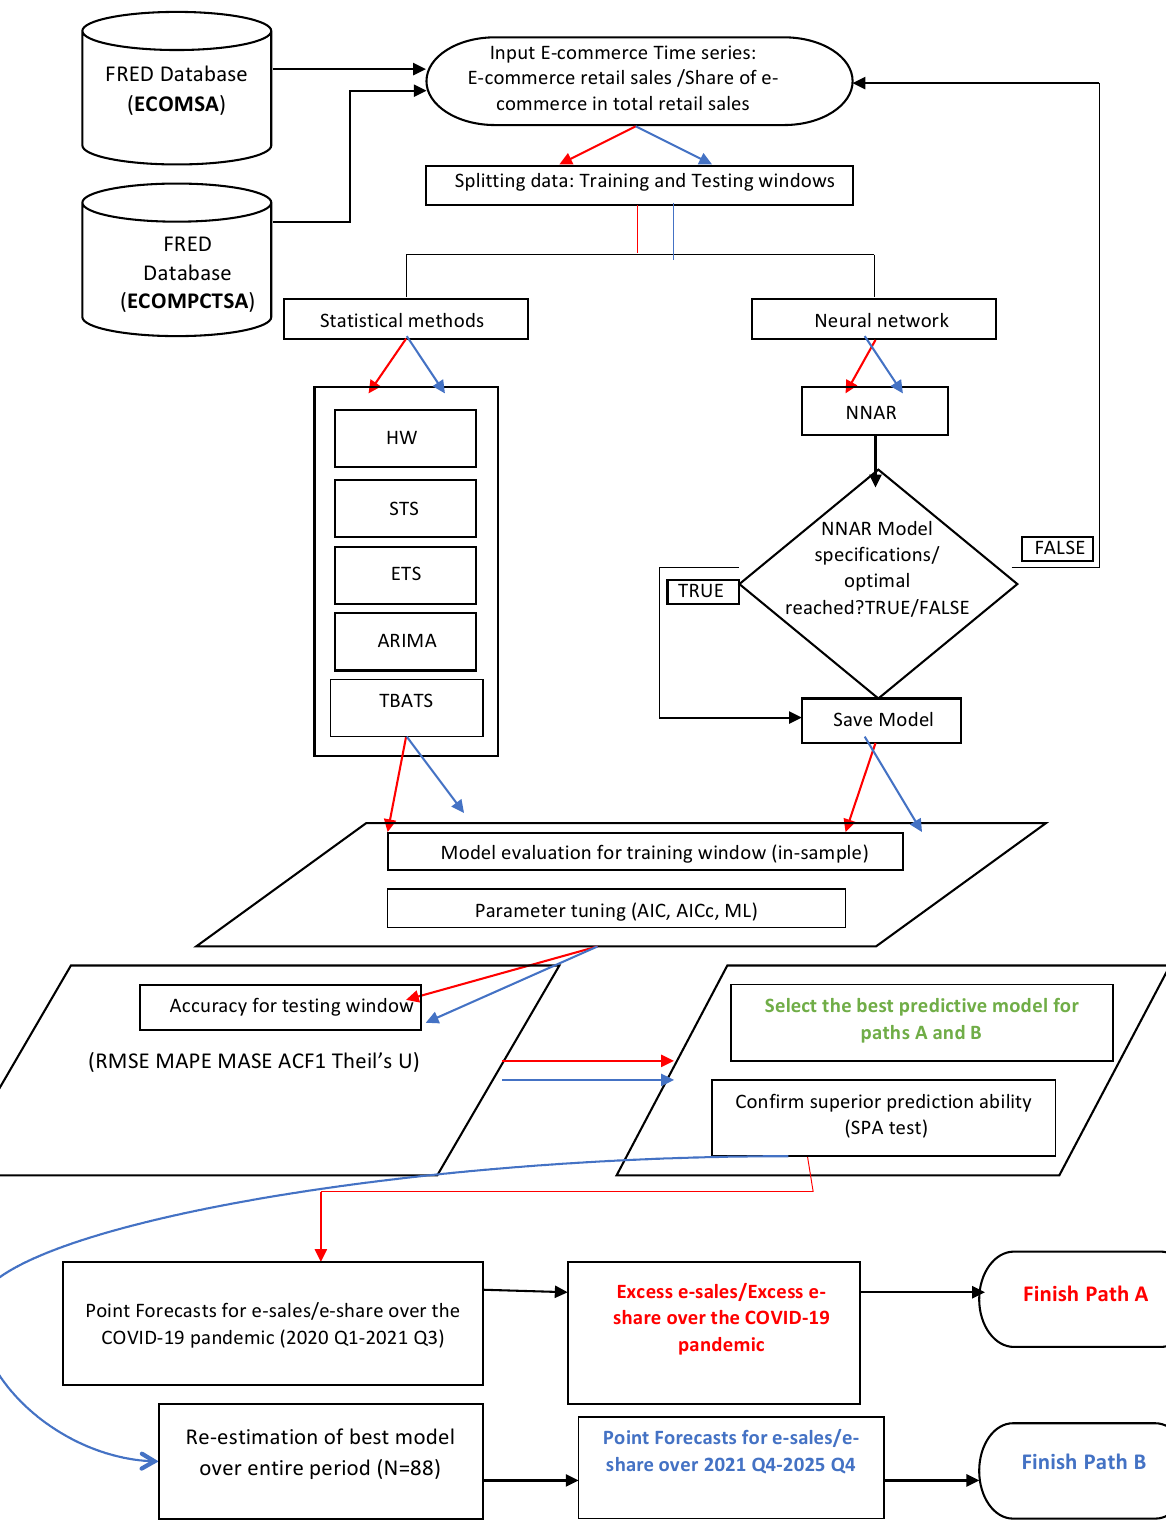
Figure 4. Integrated framework for forecasting e-commerce sector variables (i.e., e-commerce retail sales ECOMSA) and share of e-commerce in retail sales (ECOMPCTSA) where the algorithm follows subsequently path A (red color) and path B (blue color).